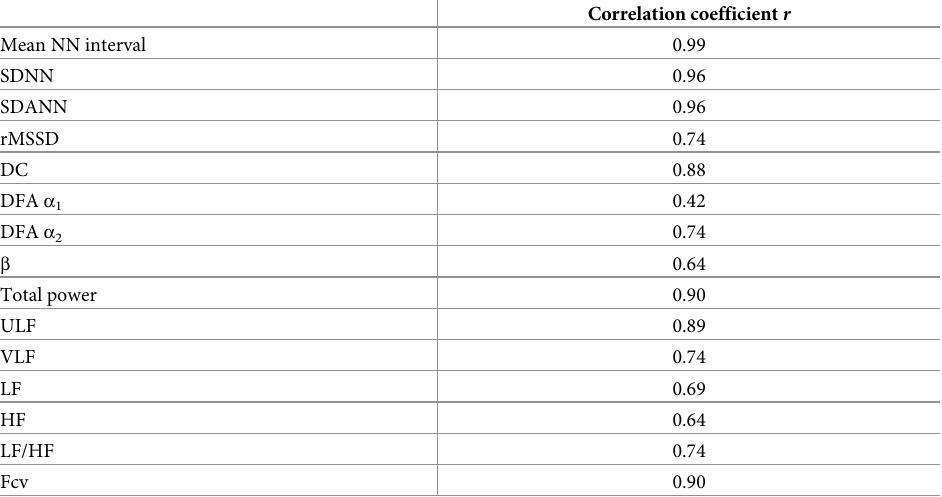
Table 2. Correlations between pulse interval and R-R interval variability indices calculated from simultaneously recorded photoplethysmography (PPG) and electrocardiography (ECG) (n = 41).